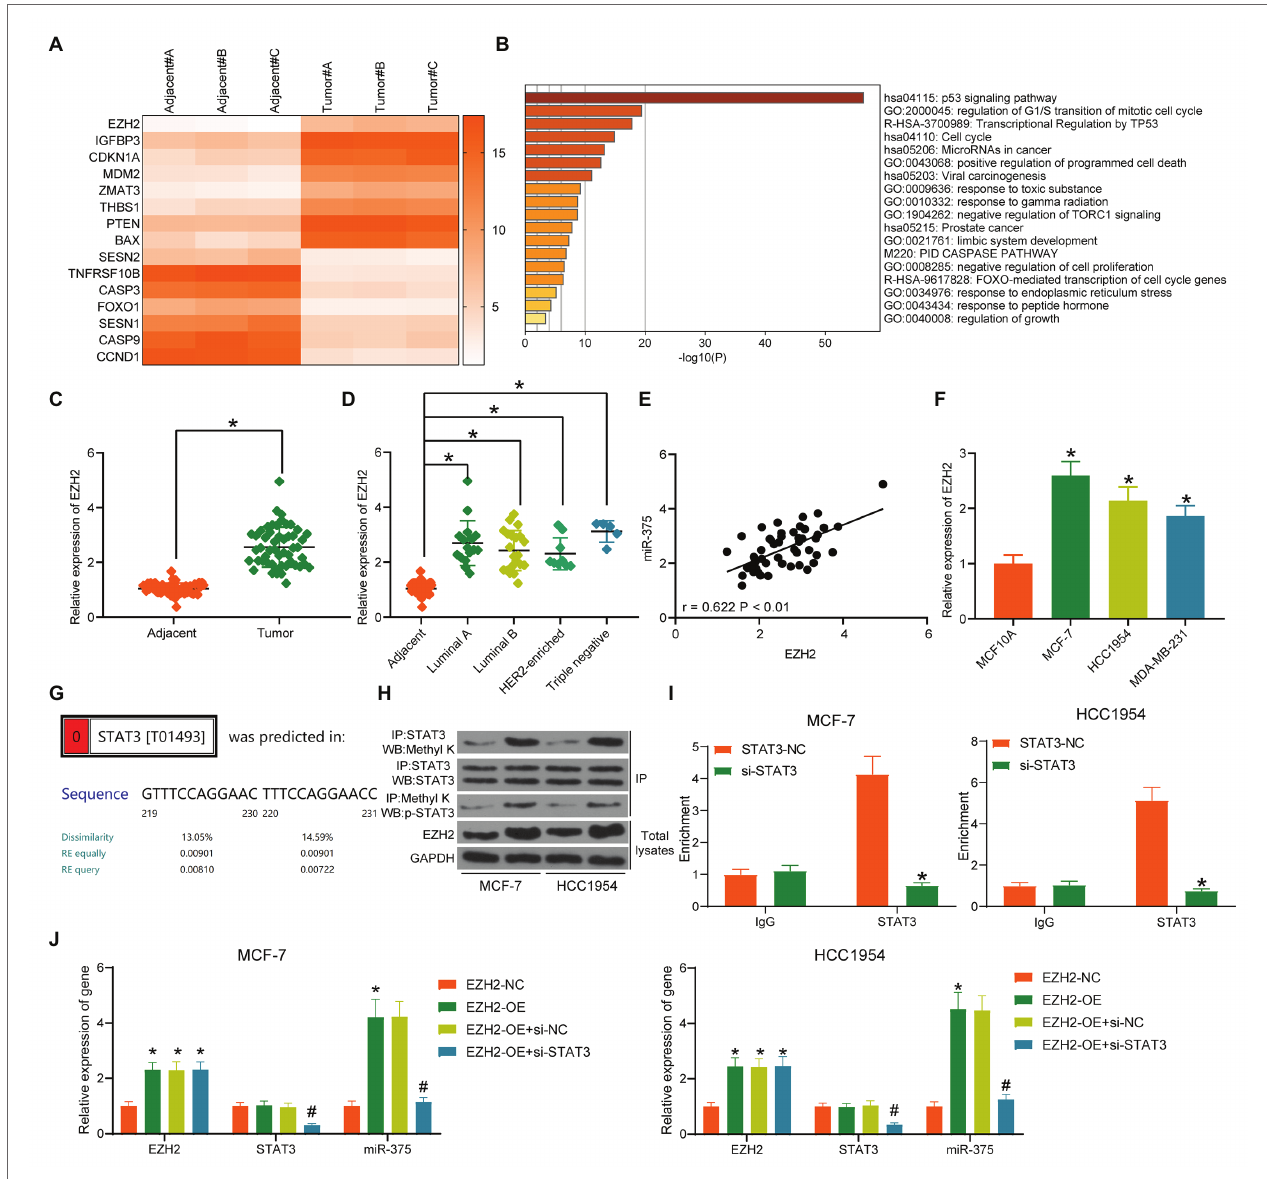
FIGURE 4 | EZH2 enhances miR-375 expression through STAT3 methylation. (A) Differentially expressed mRNAs between cancer and normal tissues screened out by microarray analysis; (B) bioinformatic analysis of the enriched pathways of the differentially genes; (C) EZH2 expression in tumor and adjacent normal tissues examined by RT-qPCR (* p < 0.05, paired t test); (D) EZH2 expression in different BC subtypes determined by RT-qPCR (* p < 0.05, one-way ANOVA); (E) a positive correlation between EZH2 and miR-375 expression in BC tissues; (F) mRNA expression of EZH2 in BC and normal cells detected by RT-qPCR; (G) putative binding relationship between STAT3 and miR-375 promoter; (H) methylation of STAT3 mediated by EZH2 determined by a Co-IP assay; (I) binding relationship between STAT3 and the miR-375 promoter region determined by a ChIP assay (* p < 0.05, two-way ANOVA); (J) expression of miR-375 in MCF-7 and HCC1954 cells after EZH2-OE and si-STAT3 transfection determined by RT-qPCR (* # p < 0.05, two-way ANOVA; *EZH2-NC vs. EZH2-OE; #EZH2-OE+si-NC vs. EZH2-OE+si-STAT3). Data were presented as mean ± SD from three independent